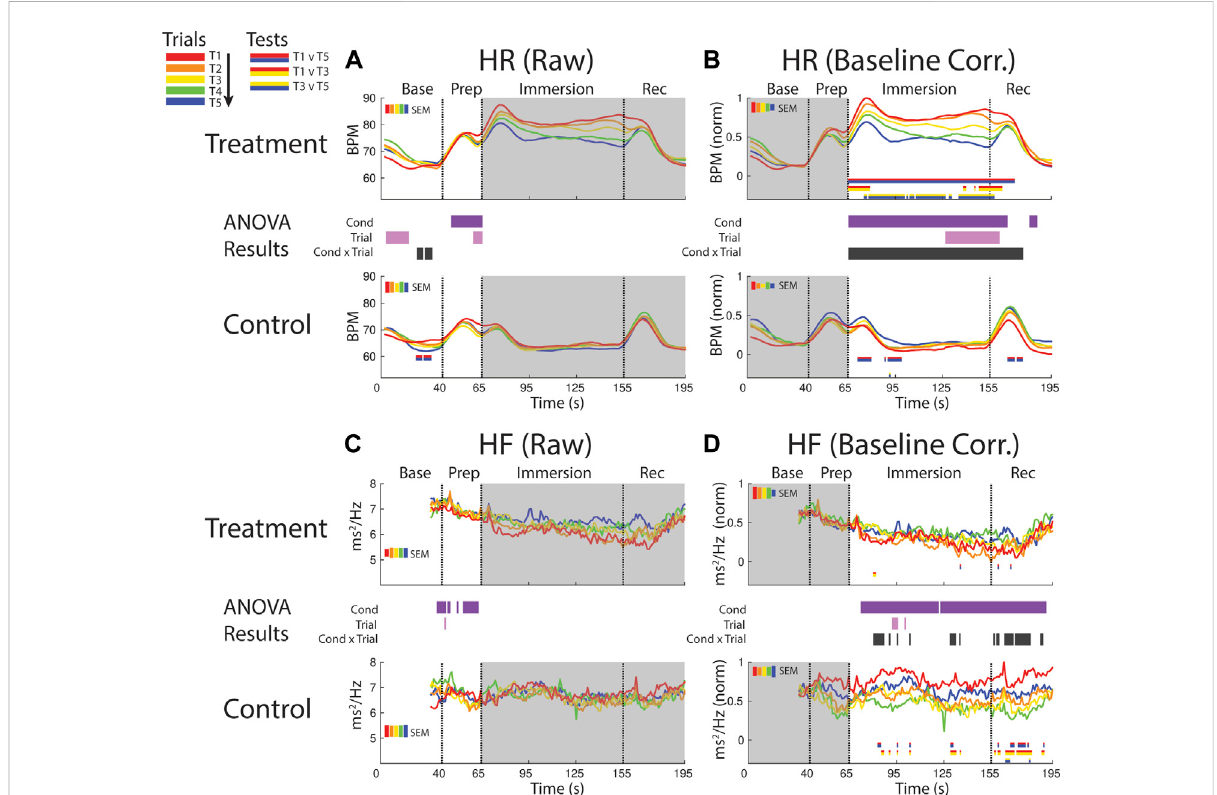
FIGURE 4 Effects of treatment and repeated trial exposure on heartbeat rate [HR; (A , B) ] and high frequency HR variability [HF; (C , D) ]. Pre-exposure and evoked stress effects are re fl ected in raw (left column) and baseline corrected/normalized (right column) plots, respectively. Each panel contains a separate plotfor thetreatmentandcontrolcondition, with themeanresponseacrossparticipantsineachrepetitiontrial(T1-T5)representedineach plotby adifferentcolor (ROYGB).Horizontal lines positioned betweentreatment and control plotsindicate statistically signi fi cantANOVAmain effects of condition (dark purple), trial (light purple) and the condition x trial interaction (dark gray) at designated timepoints ( p null < 0.05). Horizontal red/blue,red/yellowandyellow/bluelinesatthebaseoftreatmentandcontrolplotsrespectivelyindicatestatisticallysigni fi cantpairwisecomparison results for T1 v T5, T1 v T3 and T3 v T5 at the designated timepoints ( p null < 0.05). Post-immersion raw data and pre-immersion baseline corrected normalized data are greyed out as these periods are not relevant to the pre-exposure/evoked stress analyses. The set of fi ve vertical error bars labelled SEM on each plot represent ±SEM of the data averaged over the time-course of